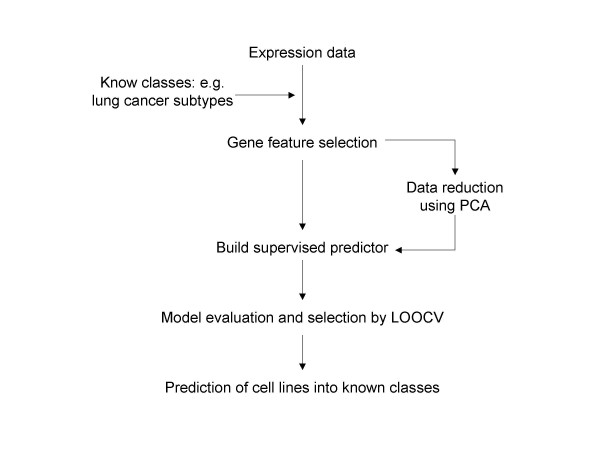
Classification of cancer cell lines using supervised learning methods. PCA: principal component analysis. LOOCV: leave-one-out cross validation.